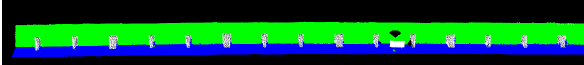
Figure 8. Experimental target